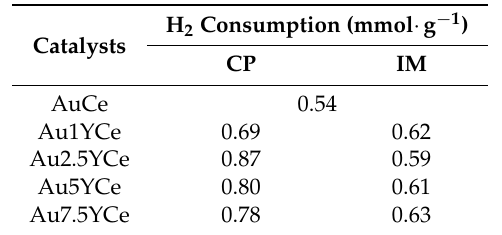
Table 2. Experimental H 2 consumption calculated for the temperature range characteristic for ceria surface layer reduction of the studied gold